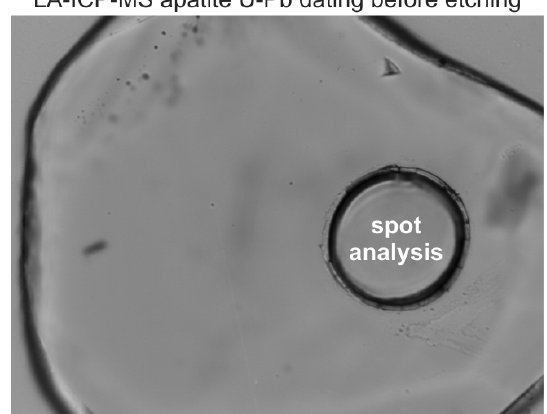
Table 2. LA–ICP-MS protocol established at LEI to be applied for simultaneous apatite U–Pb and fission-track double dating plus multielemental analysis (rare-earth elements, Y, Sr, Mn, Mg, Th, U, and Cl).